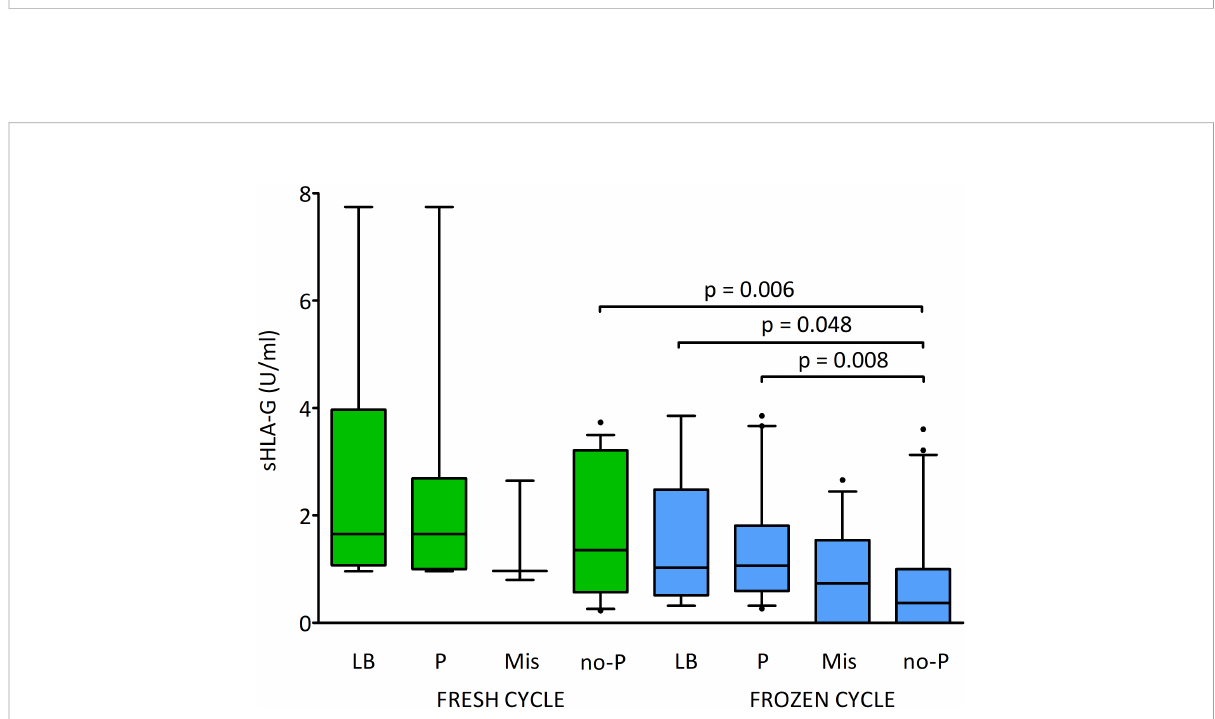
FIGURE 8 In fl uence of soluble HLA-G (U/ml) secreted by embryos and fresh/frozen cycle on the pregnancy outcome. Green boxes represent the level of sHLA-G measured in embryo media in fresh cycles, blue boxes – in frozen cycles. Boxes are drawn from the fi rst quartile (25 th percentile) to the third quartile (75 th percentile). Black lines in boxes are medians. Whiskers represent 10-90 percentiles. P-values are calculated by Mann-Whitney test. LB means live birth, P – pregnancy, MIS – miscarriage, no-P – no pregnancy.